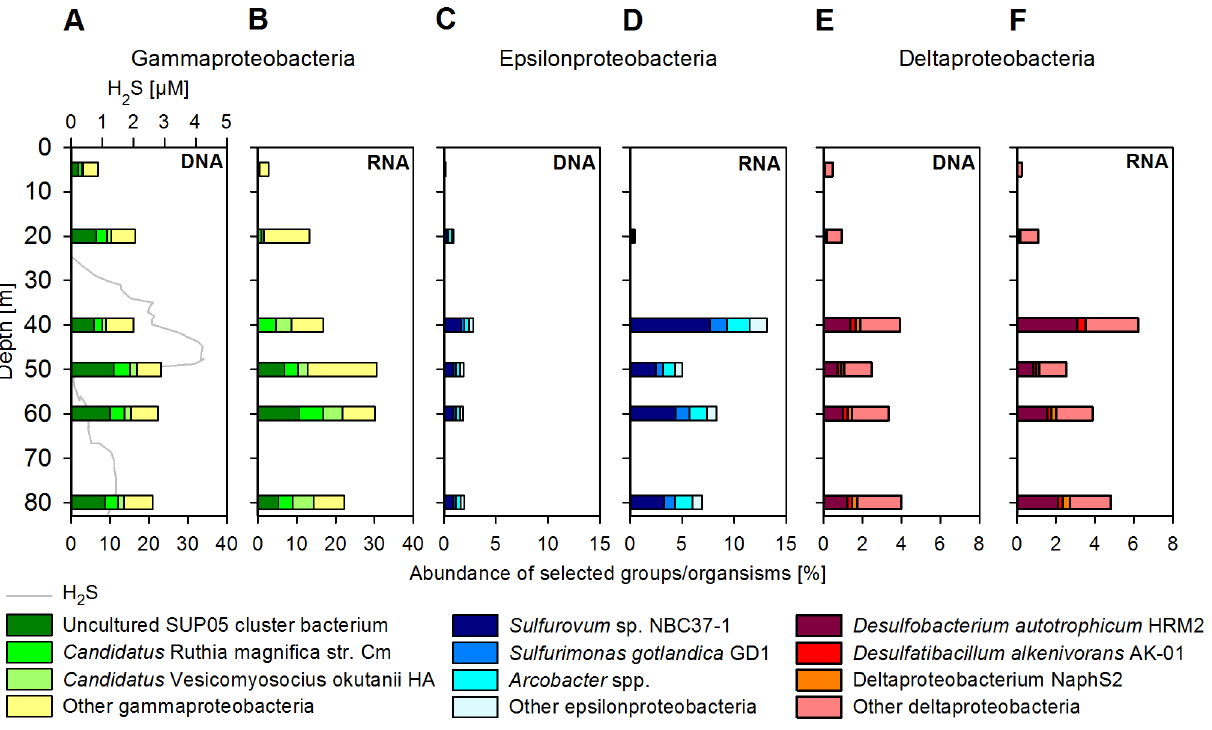
Figure 4. Vertical distribution of dominant proteobacterial taxa. Shown in percent of all sequences (excluding rRNA genes and rRNAs). (A) DNA and (B) RNA sequence abundances for c -proteobacteria. (C) DNA and (D) RNA sequence abundances for e -proteobacteria. (E) DNA and (F) RNA sequence abundances for d -proteobacteria.